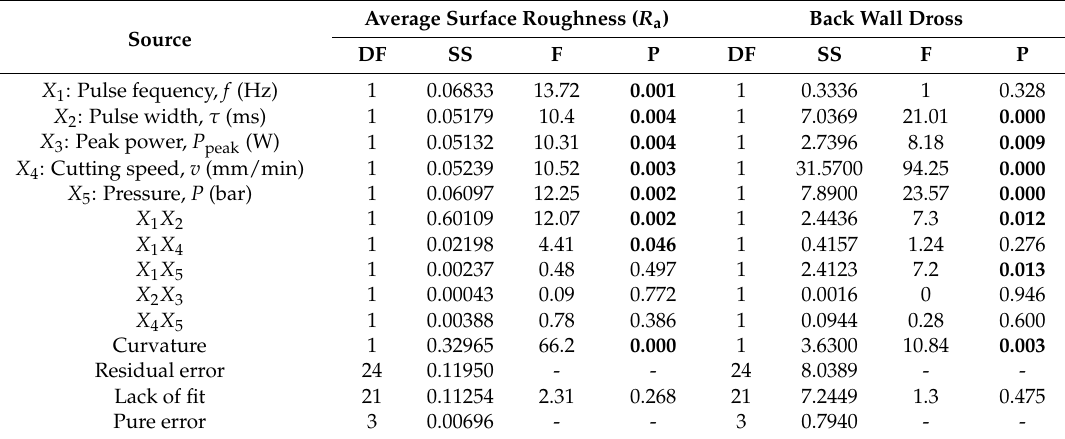
Table 6. Analysis of variance (ANOVA)—Miniature tube A